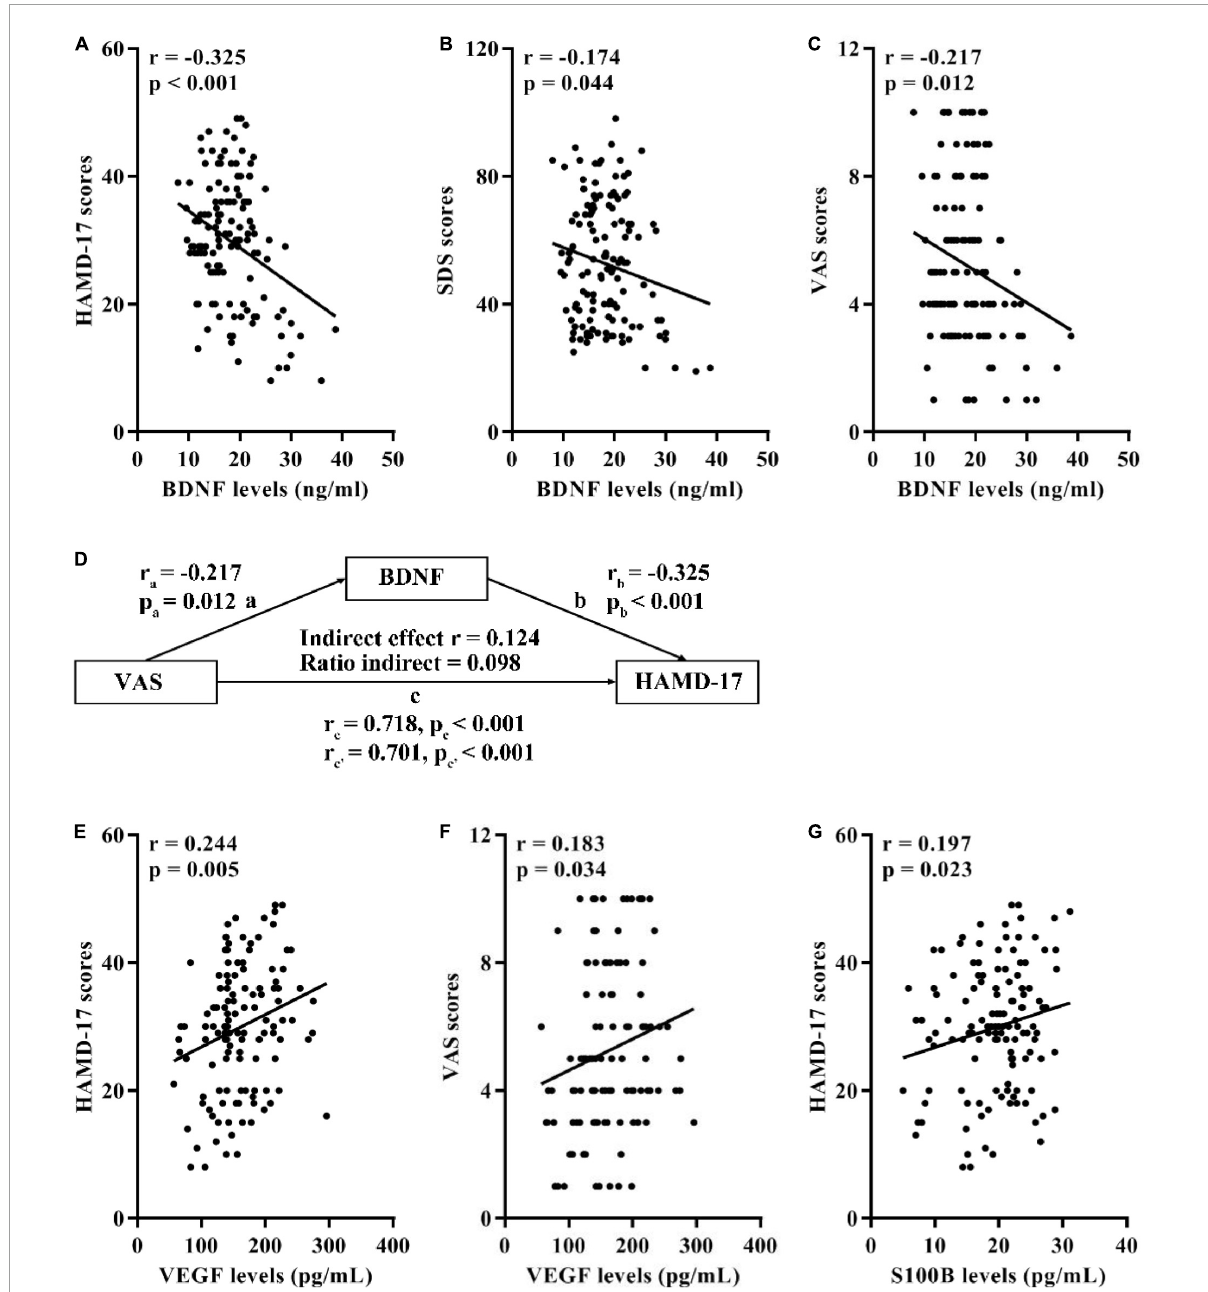
FIGURE1 Associations of serum BDNF, VEGF, and S100B with the HAMD-17, SDS, and VAS scores in 134 OA participants with MDD. (A) Correlation between BDNF levels and the HAMD-17 scores. (B) Correlation between BDNF levels and the SDS scores. (C) Correlation between BDNF levels and the VAS scores. (D) Mediation effects of serum BDNF on the association between the HAMD-17 and VAS scores. (E) Correlation between VEGF levels and the HAMD-17 scores. (F) Correlation between VEGF levels and the VAS scores. (G) Correlation between S100B levels and the HAMD-17 scores. BDNF, brain-derived neurotrophic factor; VEGF, vascular endothelial growth factor; HAMD-17, 17-item Hamilton Depression Scale; SDS, Self-Rating Depression Scale; VAS, Visual Analogue Scale; OA, osteoarthritis; MDD, major depressive